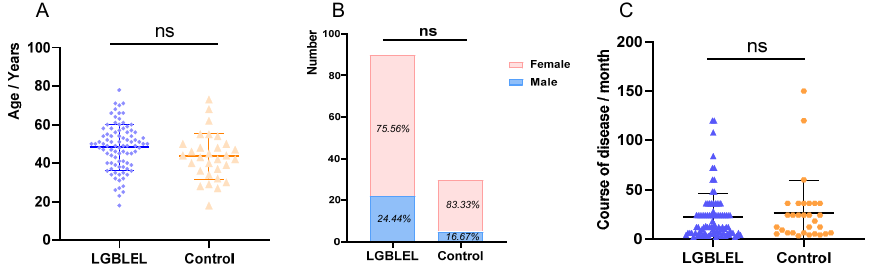
Figure 1. Comparative analysis images of general conditions of patients in LGBLEL group and control group. ( A ) Comparative analysis chart of age; ( B ) Comparative analysis chart of gender; ( C ) Comparative analysis chart of course of disease. “ns” refers to no statistically significant difference ( p > 0.05).